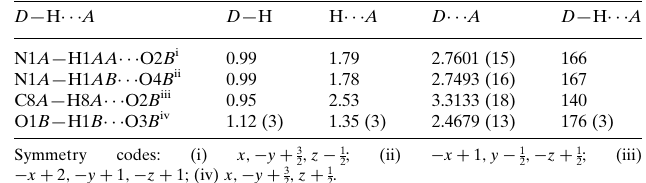
Data collection Agilent Xcalibur Eos Gemini diffractometer Absorption correction: multi-scan ( CrysAlis PRO and CrysAlis RED ; Agilent, 2012). T min = 0.840, T max = 1.000